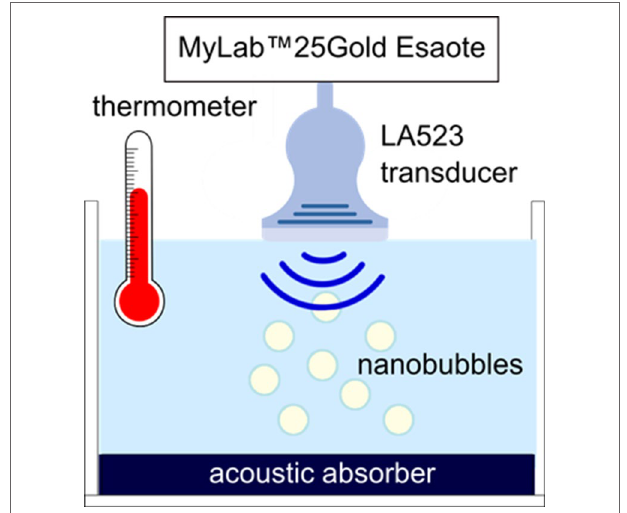
FIGURE 2 | Experimental setup used for US imaging.